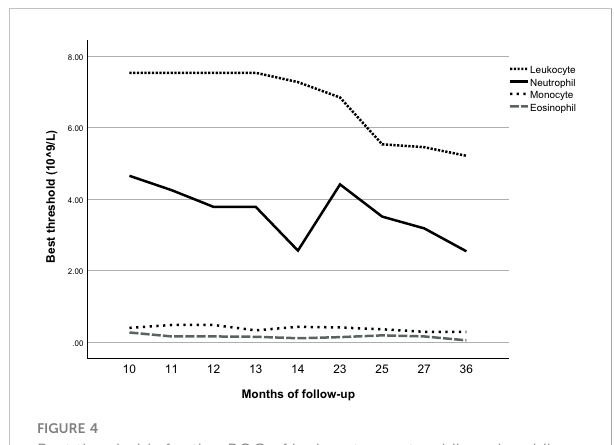
FIGURE 4 Best thresholds for timeROC of leukocyte, neutrophil, eosinophil, and